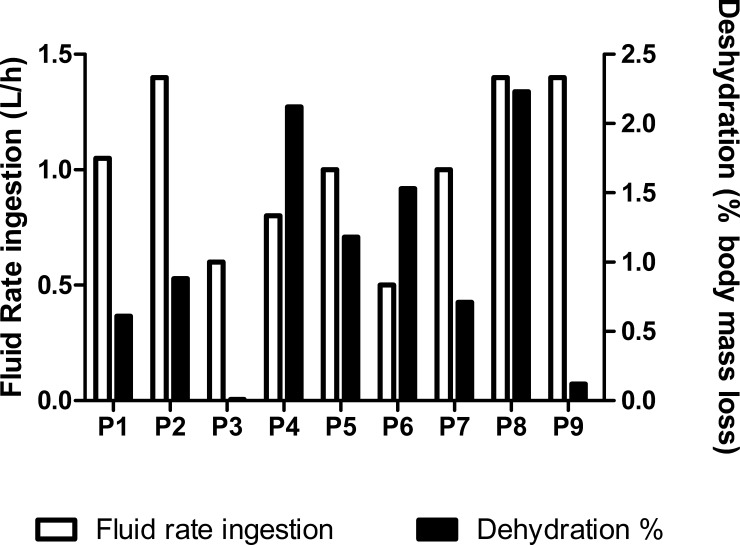
Individual response of fluid balance (L/h) and body weight lost (%) after a singles professional tennis match.